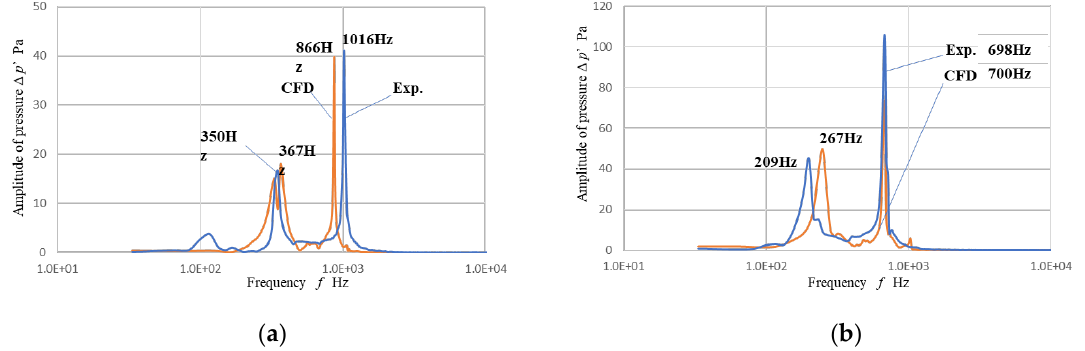
Figure 10. Spectrum of pressure amplitude. ( a ) ϕ = 6 mm. ( b ) ϕ = 10 mm.